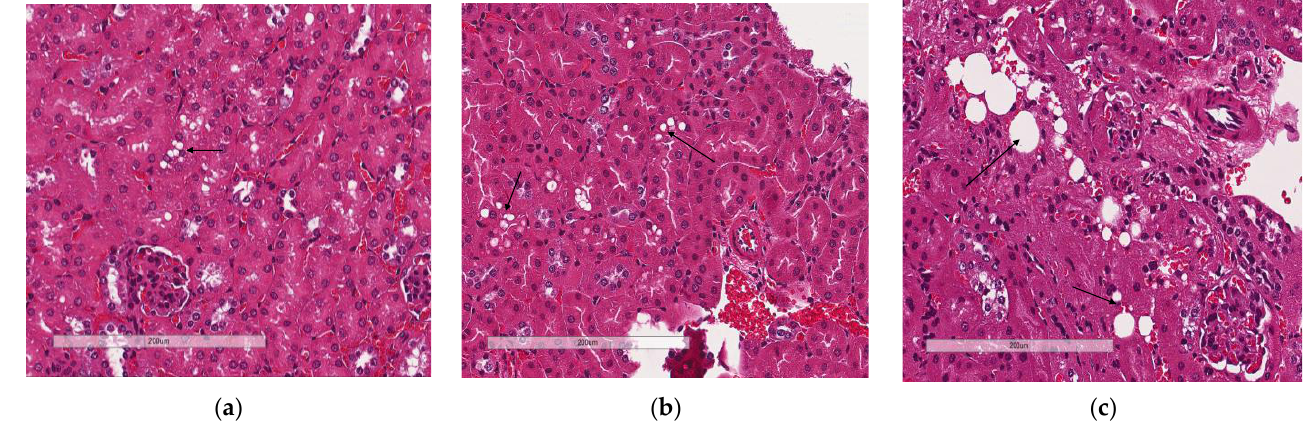
Figure 9. Effect of slc7a8 deletion on lipid accumulation in the kidneys. H&E-stained sections showed that accumulation of lipids (black arrows) was greater in WTHFD ( c ) than in WTCD ( a ) and KOHFD ( b ). Magnification = 20×. Scale bar = 200 µm.